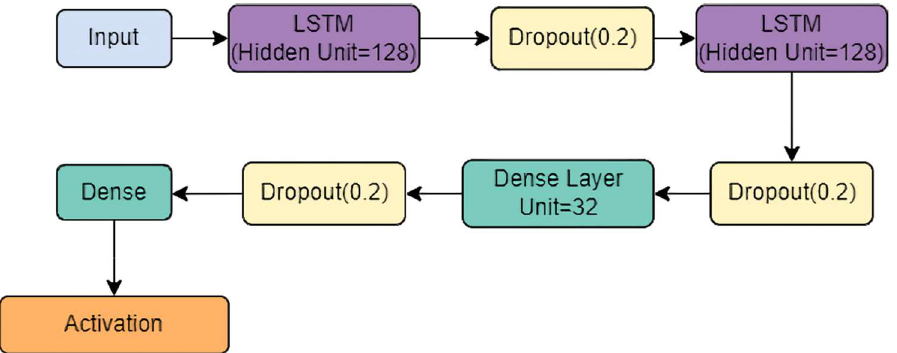
Figure 5. Schematic diagram of the StackedLSTM-net model.